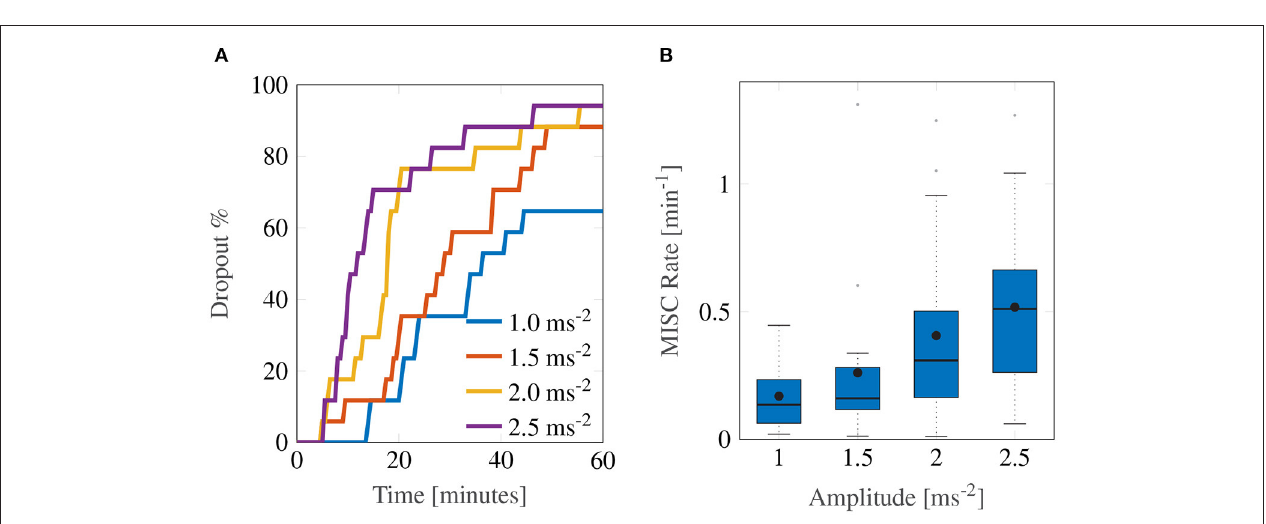
FIGURE 3 | Main group-averaged results for the first motion exposure. (A) indicates the early termination rate where participants reached a MISC level of 6 prior to the 60-min mark in first motion exposure. (B) shows the median MISC Rate (as the solid black line inside blue shaded box) the mean MISC Rate (black circle) and the 25th and 75th percentiles (bounds of the